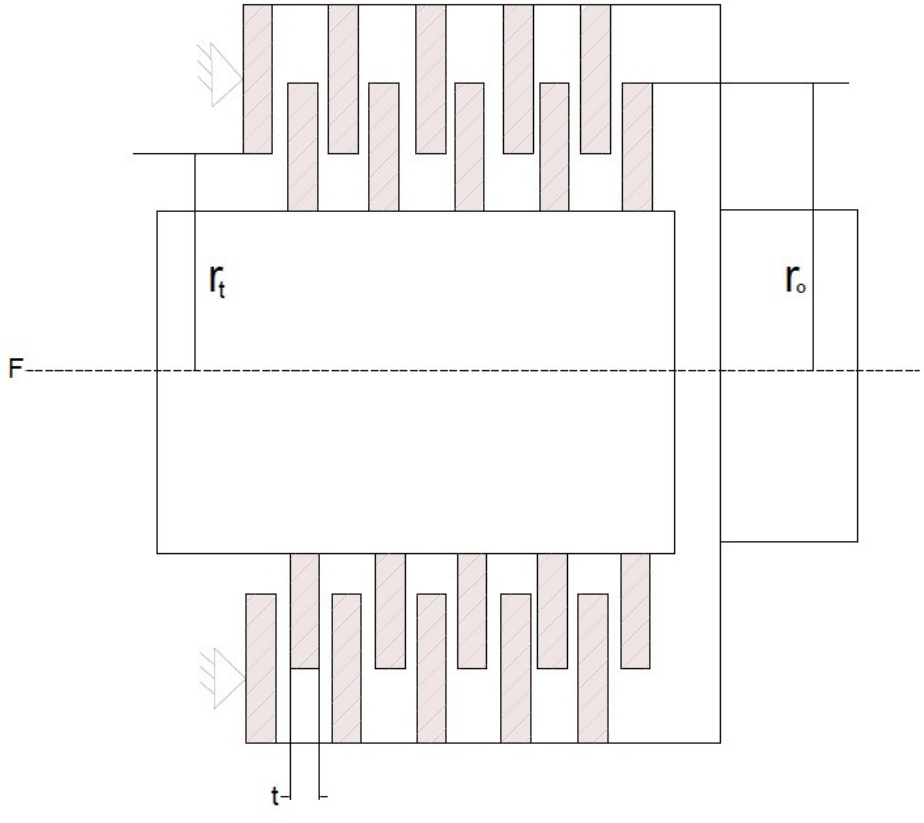
Figure 7. The multiple disc clutch brake